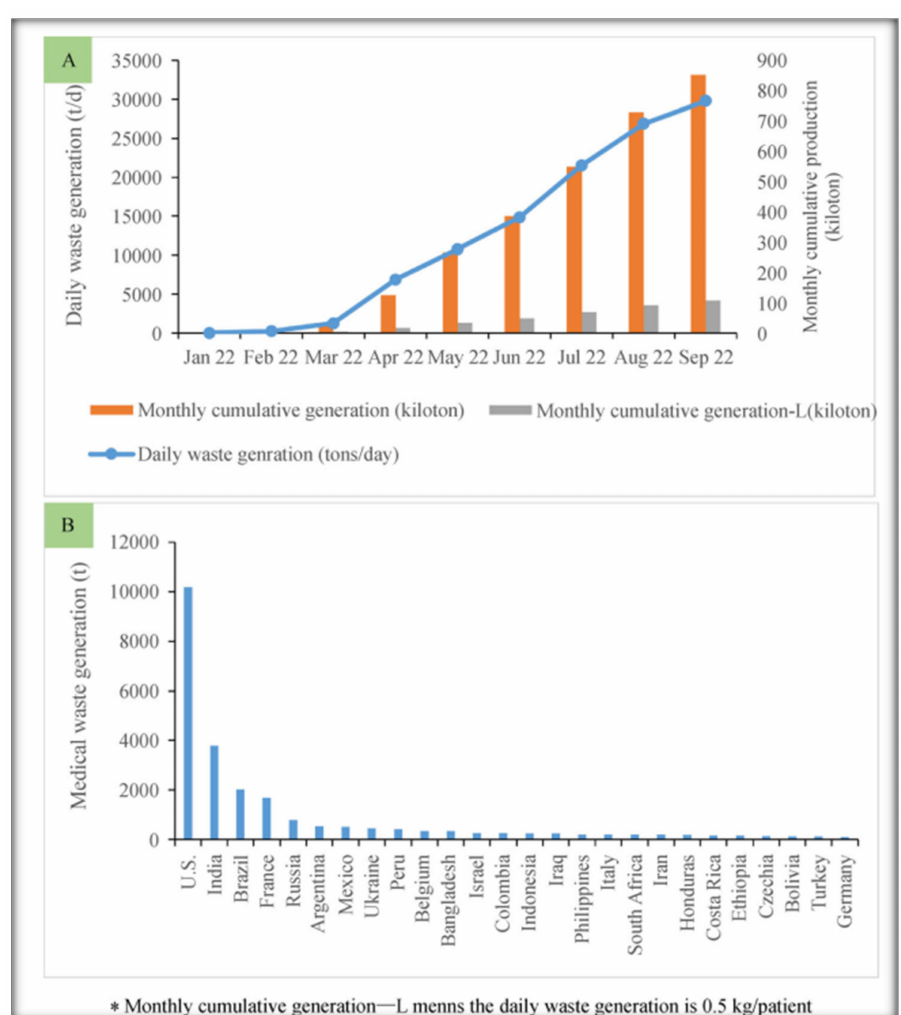
Figure 1. Estimation of COVID-19-related medical waste generation around the world